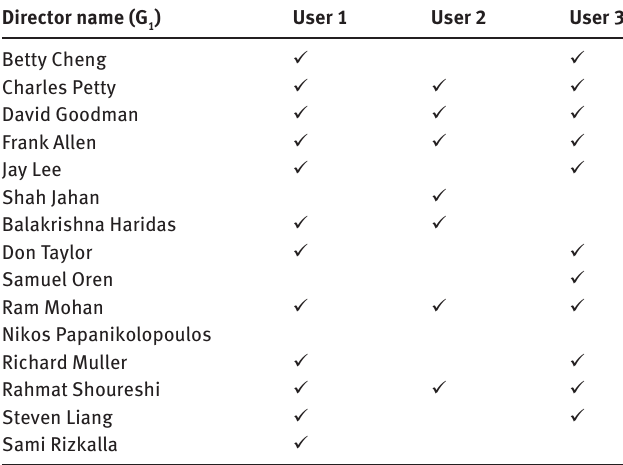
Table 1. Recognition Data for Directors’ Names ( G